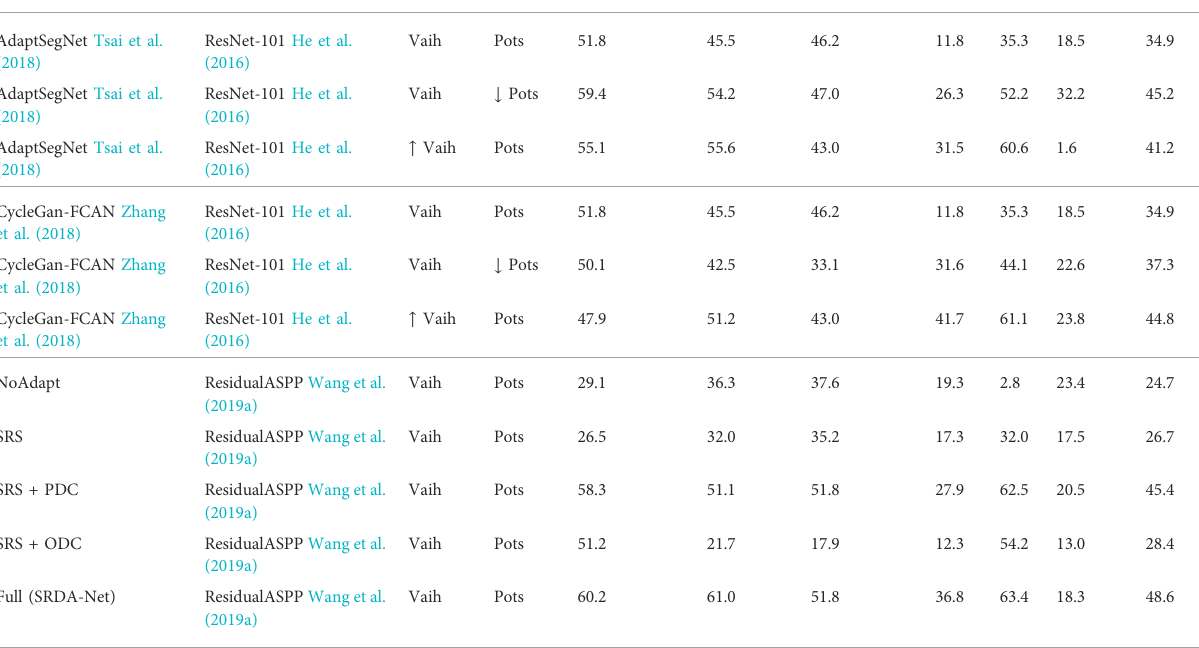
TABLE 2 Comparison results of domain adaptation from Vaih to Pots val